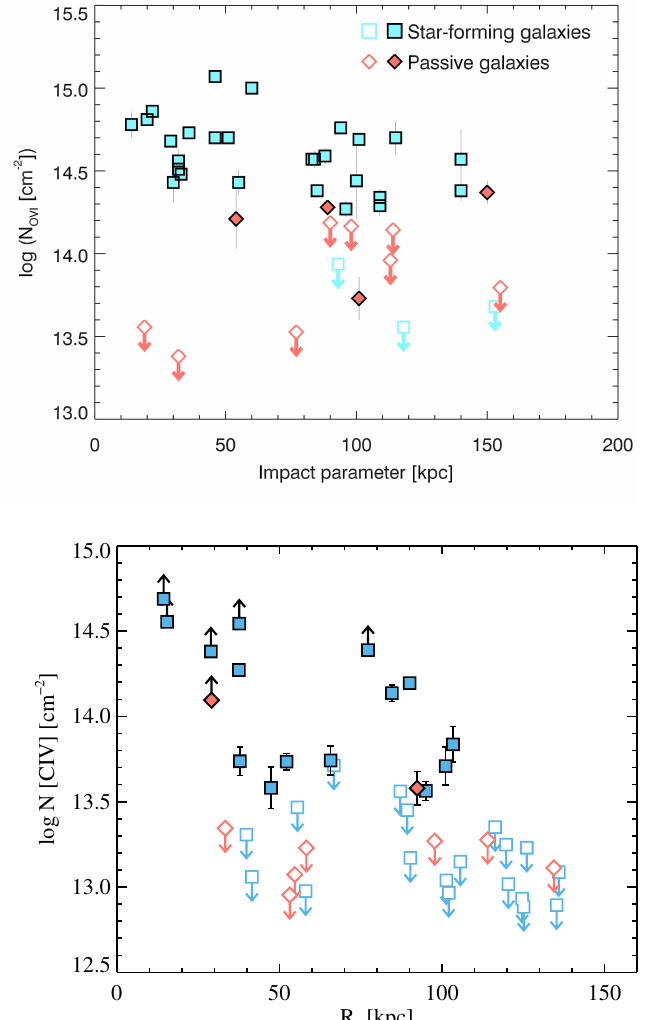
Figure 4. The radial profiles (in terms of the projected radius) of OVI ions in circumgalactic halos of the COS-halos survey—( upper panel ). Credit Tumlinson et al. [95], and of CIV ions in CGM of the COS-dwarfs survey ( lower panel ) from [97], lower left panel on their Figure 2. Reproduced with permission from R. Bordoloi et al., published by AAS (ApJ) 2014. Blue squares and red diamonds represent column densities in star-forming and passive galaxies, correspondingly; the filled symbols depict detections, while the open with downward arrors depict non-detections within 2 σ